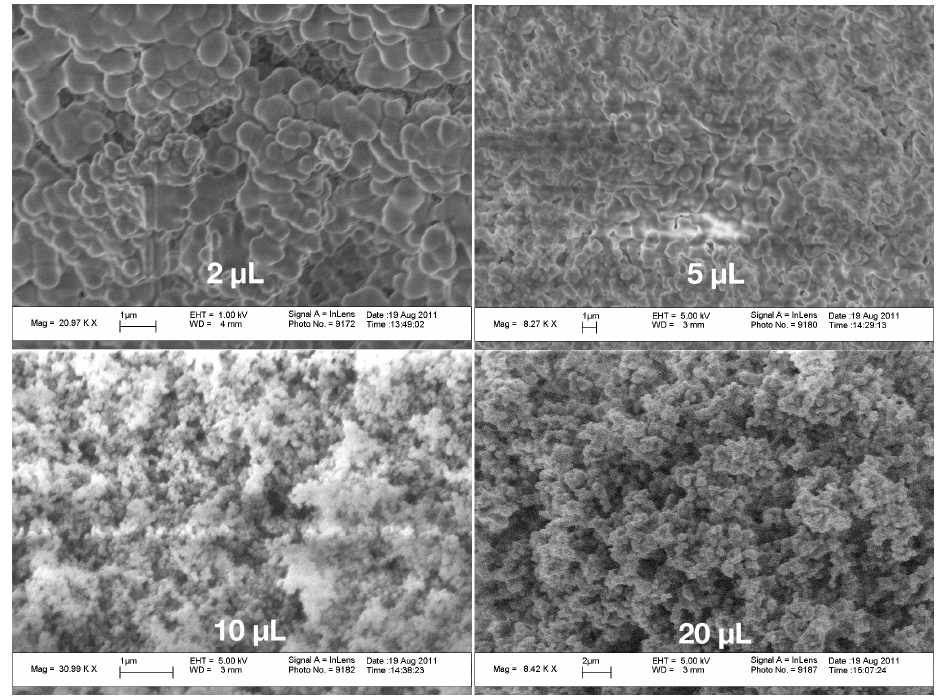
Figure 3. Scanning electron microscopic image of the fracture surface of a drop with 2 µ L ( upper row left ), 5 µ L ( upper row right ), 10 µ L ( lower row left ) and 20 µ L ( lower row right